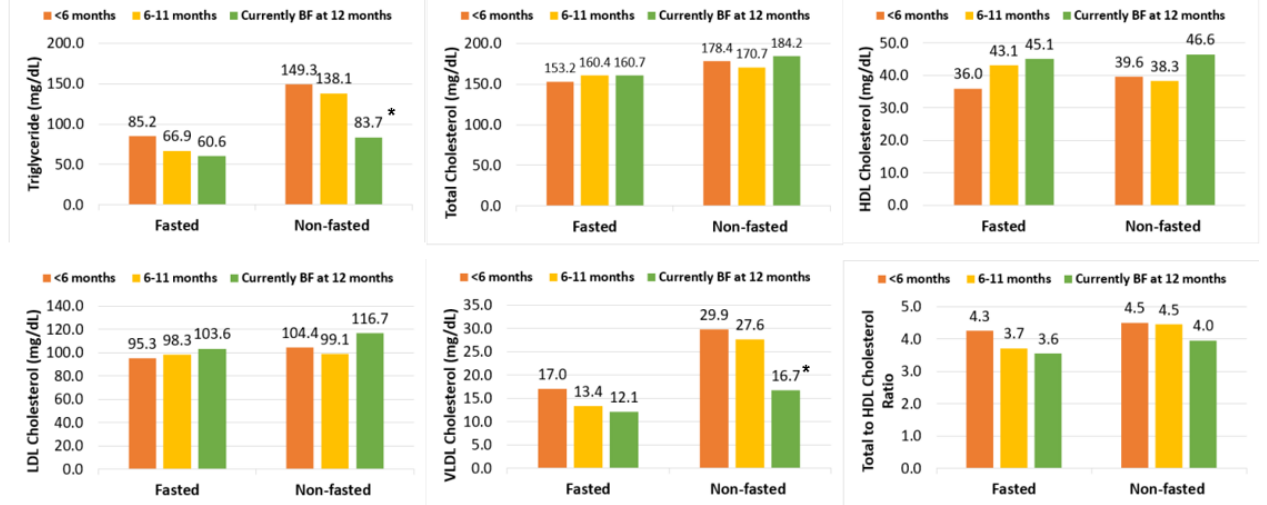
Figure 1. Exponentiated marginal means † of 12-month postpartum lipids by breastfeeding duration, stratified by fasting status. BF = breastfeeding. † Model estimates were back-transformed and presented as exponentiated marginal means for interpretability. * p < 0.05 compared to breastfed <6 months. Sample size ( n ) = 13, 14, 14 for breastfeeding ≥ 12 months, 6–12 months, and <6 months among non-fasted samples, respectively; Sample size ( n ) = 14, 10, 14 for breastfeeding ≥ 12 months, 6–12 months, and <6 months among fasted samples, respectively. All means were adjusted for maternal age, country of origin, marital status, household annual income, education, pre-pregnancy BMI and birth